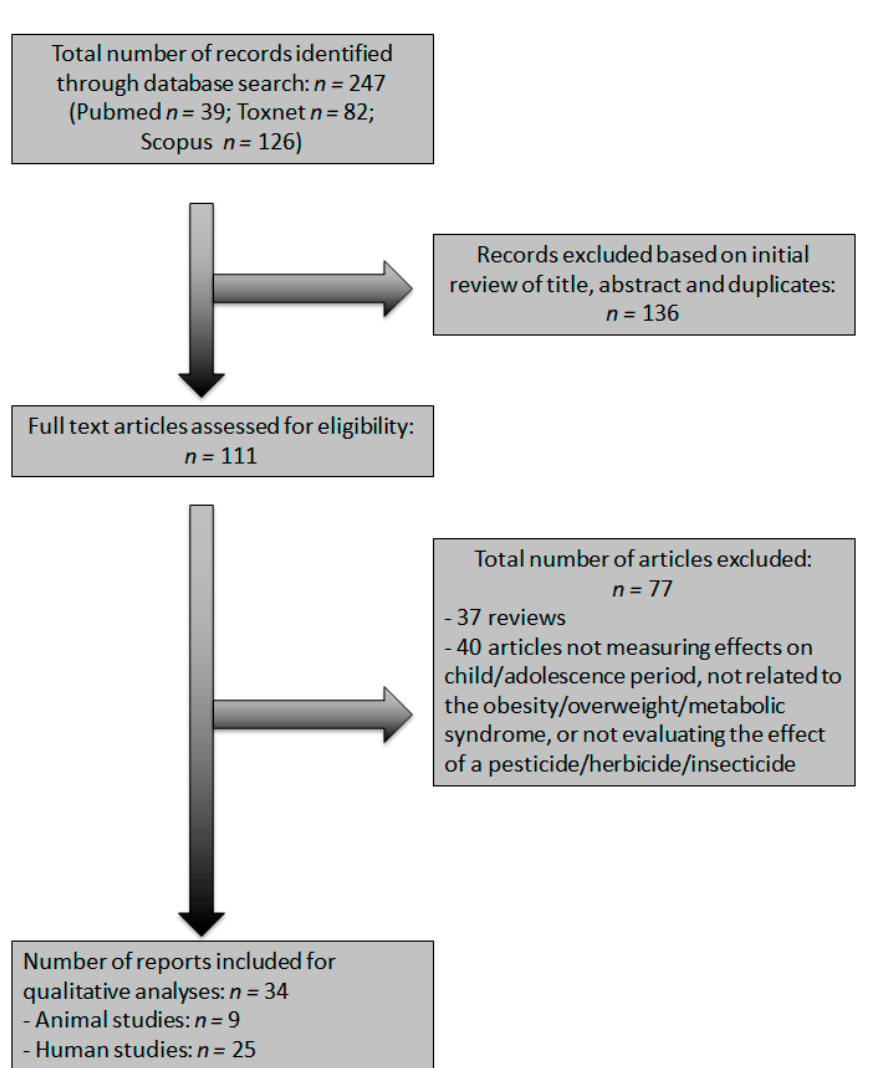
Figure 1. PRISMA (Preferred Reporting Items for Systematic Reviews and Meta-Analyses) flow chart.